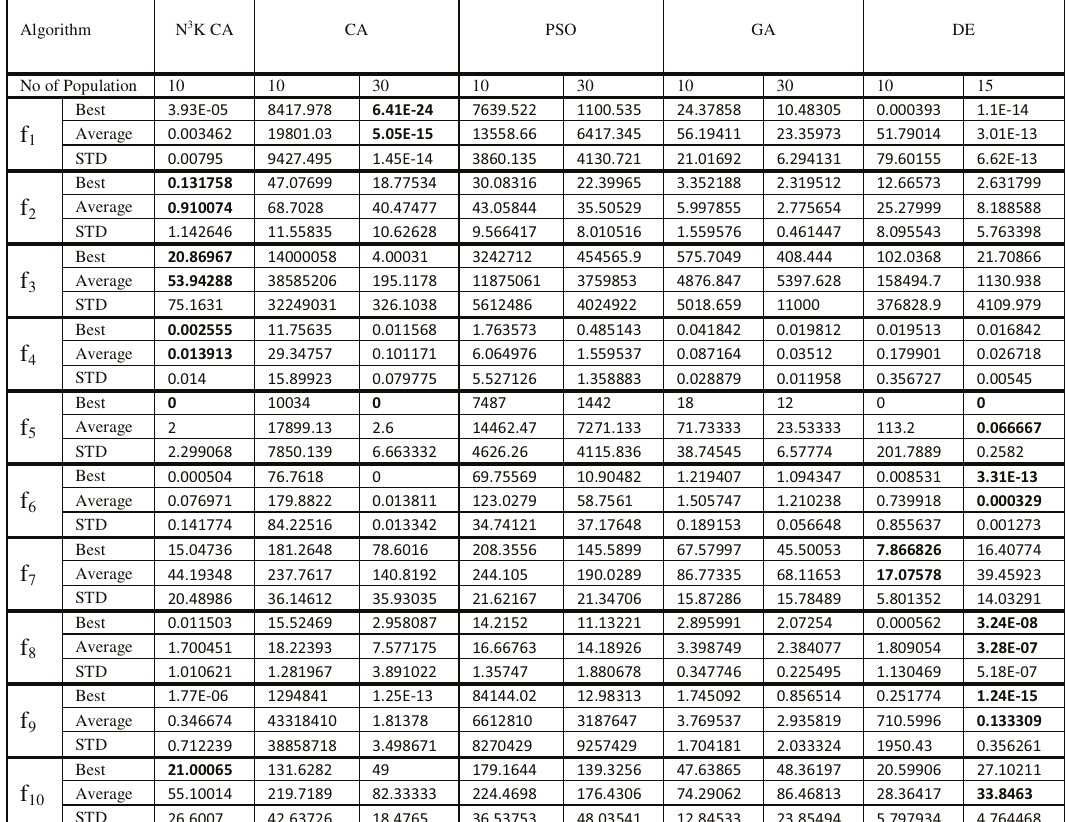
Table 5. Search Result Comparison of N 3 KCA, CA, PSO, GA, DE And Ten Test functions. The dimension of the functions is set to 30 and the simulations are repeated for 15